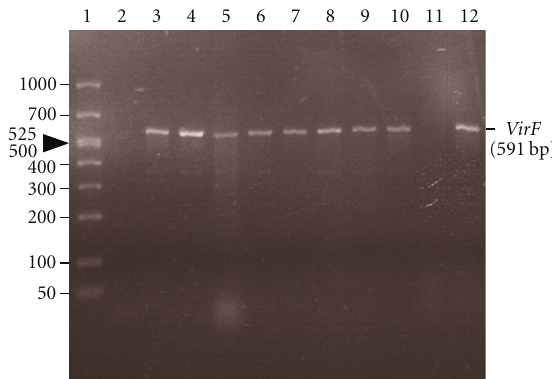
Figure 4: Confirmation of presence of pYV of Y . pestis in the original strain before subculturing, and CR-positive clones from CR-MOX, CR-BHO, and BHI broth using PCR assay targeting a key regulatory gene virF from pYV. The primer pairs (5 (cid:3) -TCATGGCAGAACAGCAGTCAG-3 (cid:3) and 5 (cid:3) - ACTCATCTTACCATTAAGAAG-3 (cid:3) ) for detection of the virF gene (430- to 1020-nucleotide region) amplified a 591-bp-product from the virulence plasmid. The Lcr-CR + clones showed the presence of 591 bp products from pYV (lanes 2–10 and 12). Lane 1, 50–1,000 bp ladder marker; lane 2, negative control with no template; lane 3, original KIM5 strain as positive control; lanes 4, 5, Lcr-CR + colonies from the CR-MOX and CR-BHO respectively (Figure 5 ; no. 1); lane 6 BHI broth (Figure 5; 1st passage; no. 2); lane 7 s tock culture on CR-MOX (no. 3; 1st passage); lane 8 stock culture on CR-BHO (no. 3; 1st passage); lane 9 BHI broth (no. 4, 2nd passage from CR- MOX); lane BHI broth 10 (no. 4, 2nd passage from CR-BHO); lane 11 (no. 5, 2nd passage on CR-MOX) showing the absence of 591-bp product, and lane 12 (no. 5, 2nd passage on CR-BHO)